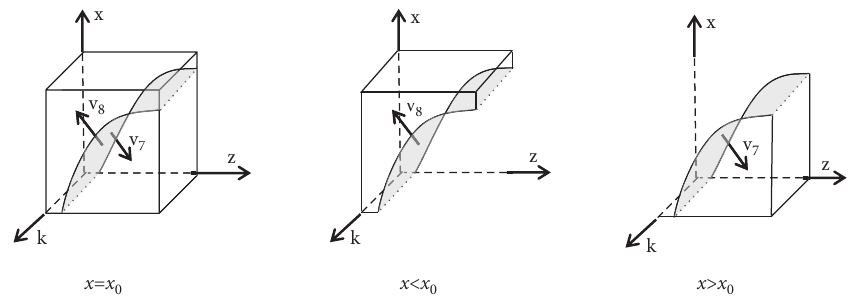
Figure 4: Phase diagram of enterprises strategy selection. (a) x � x